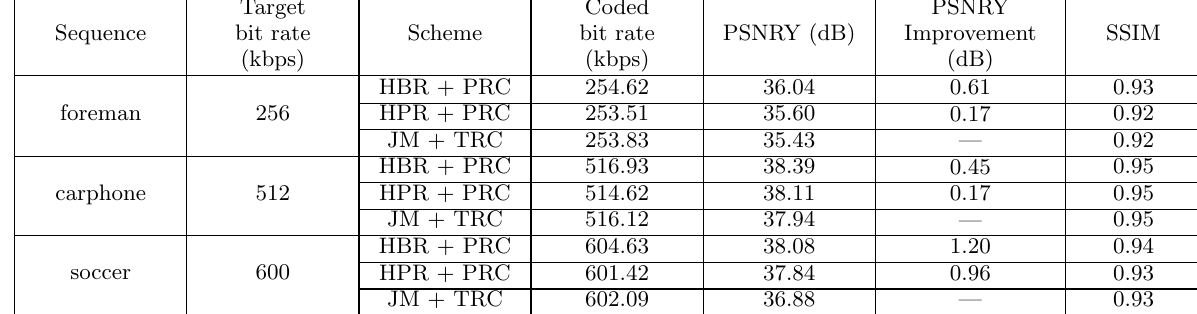
Table 2: Experimental Results on CIF Test